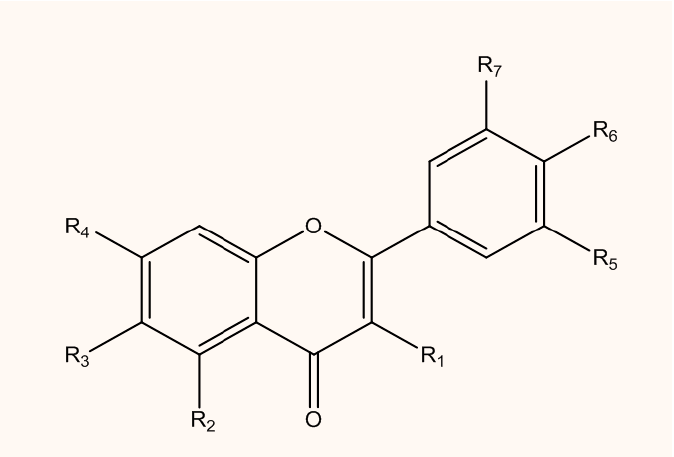
Figure 1. The chemical structure of quercetin (QC). The changing of functional groups makes derivatives of